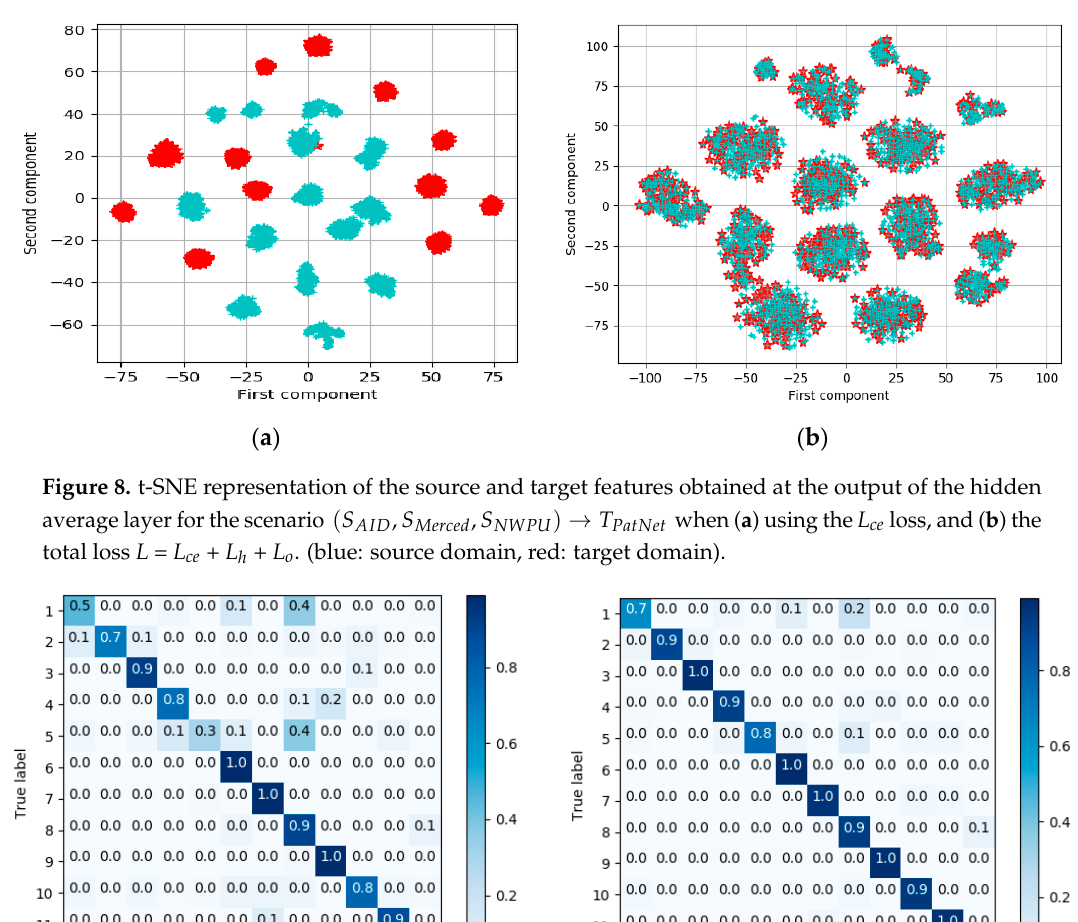
( a ) ( b ) Figure 10. Confusion matrices for Merced using: ( a ) 𝐿 (cid:3030)(cid:3032) loss, and ( b ) the total loss 𝐿 = 𝐿 (cid:3030)(cid:3032) + 𝐿 (cid:3035) + 𝐿 (cid:3042) . ( a ) ( b ) Figure 11. Confusion matrices for NWPU using: ( a ) 𝐿 (cid:3030)(cid:3032) loss, and ( b ) the total loss 𝐿 = 𝐿 (cid:3030)(cid:3032) + 𝐿 (cid:3035) + 𝐿 (cid:3042) .